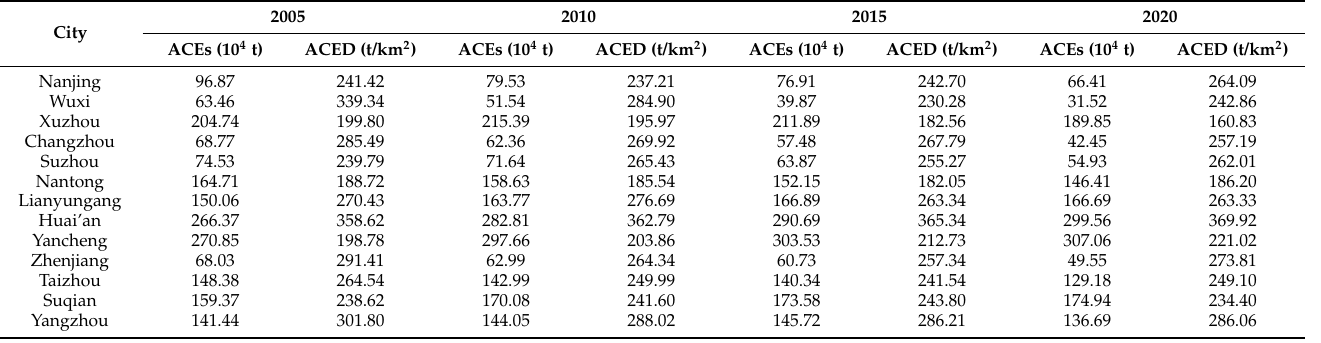
Table 4. Changes in ACEs and ACED in Main Years.